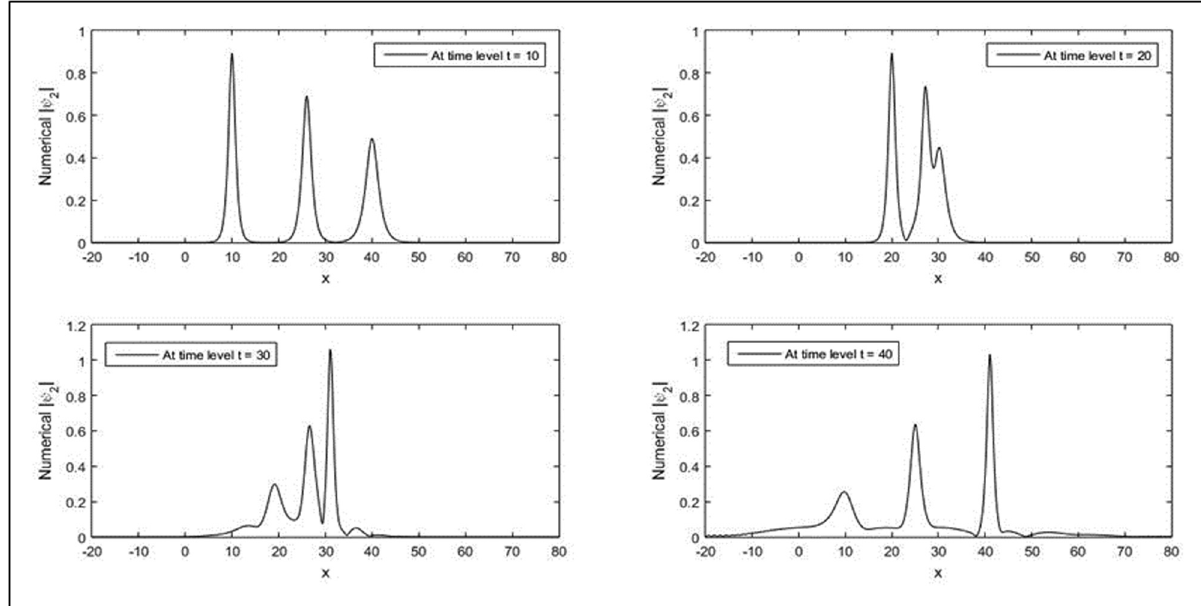
Figure 12: Interaction of three solitons for second - wave amplitude